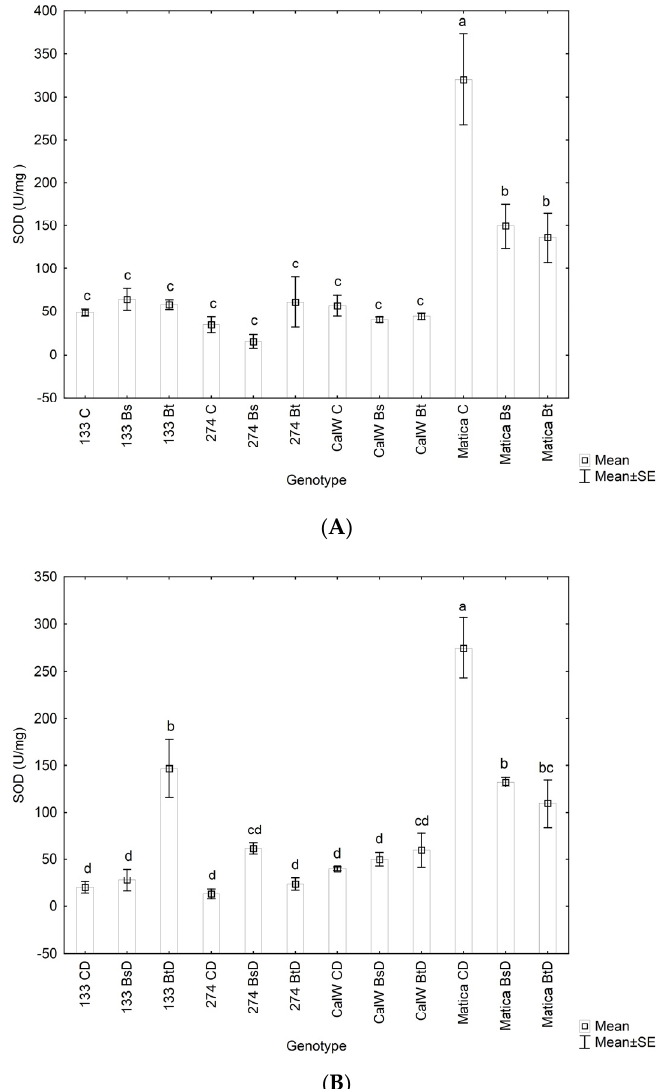
Figure 1. The activity of superoxide dismutase (SOD) in leaves of four pepper genotypes in ( A ) control (C) and ( B ) drought (D) conditions treated with two bacterial strains, B. safensis SS-2.7—Bs and B. thuringiensis SS-29.2—Bt. Different letters show significant differences between genotypes ( p < 0.05) according to Duncan’s test.